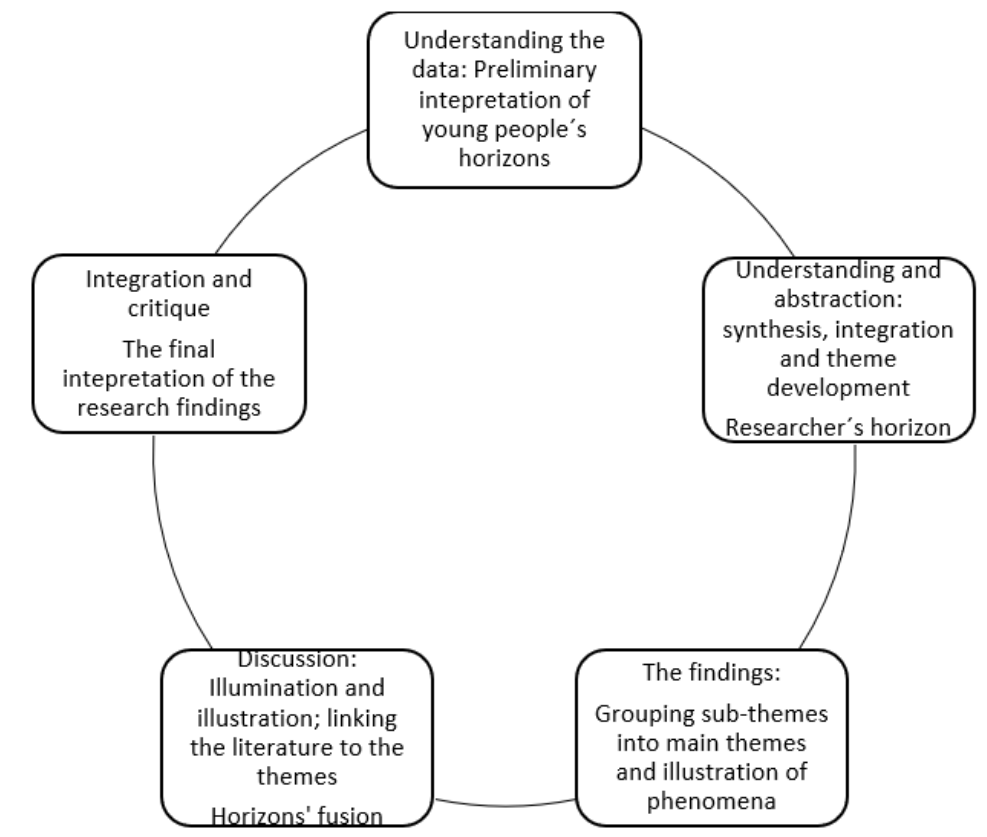
Figure 2. Intepretation of findings in the Hermeneutic Circle.